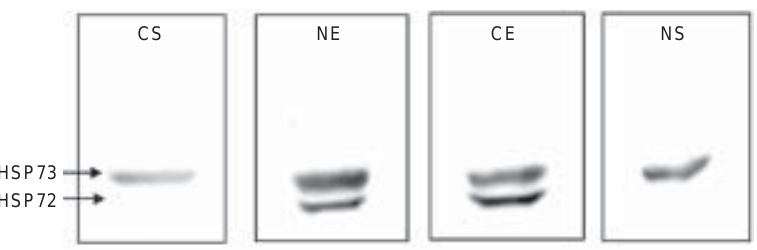
sedentary.HSP73 HSP72